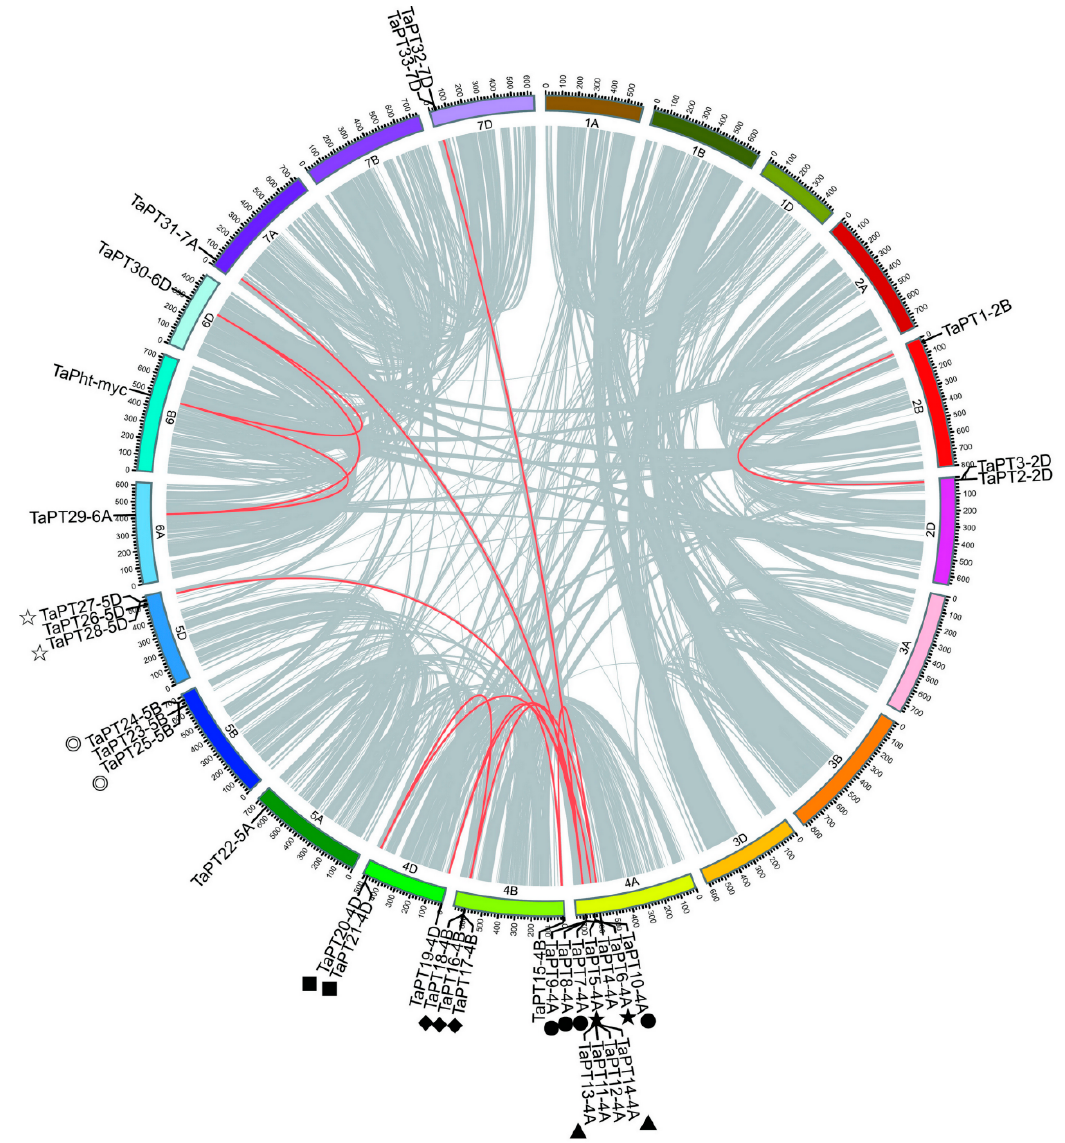
Figure 3. Chromosomal positions and synteny relationships of the PHT1 genes in the wheat genome. All syntenic blocks (more than 300 anchor genes) and genes are linked by the grey lines, and segmental duplication pairs of TaPHT1 genes are highlighted by red lines. Different symbols indicate seven tandem regions.